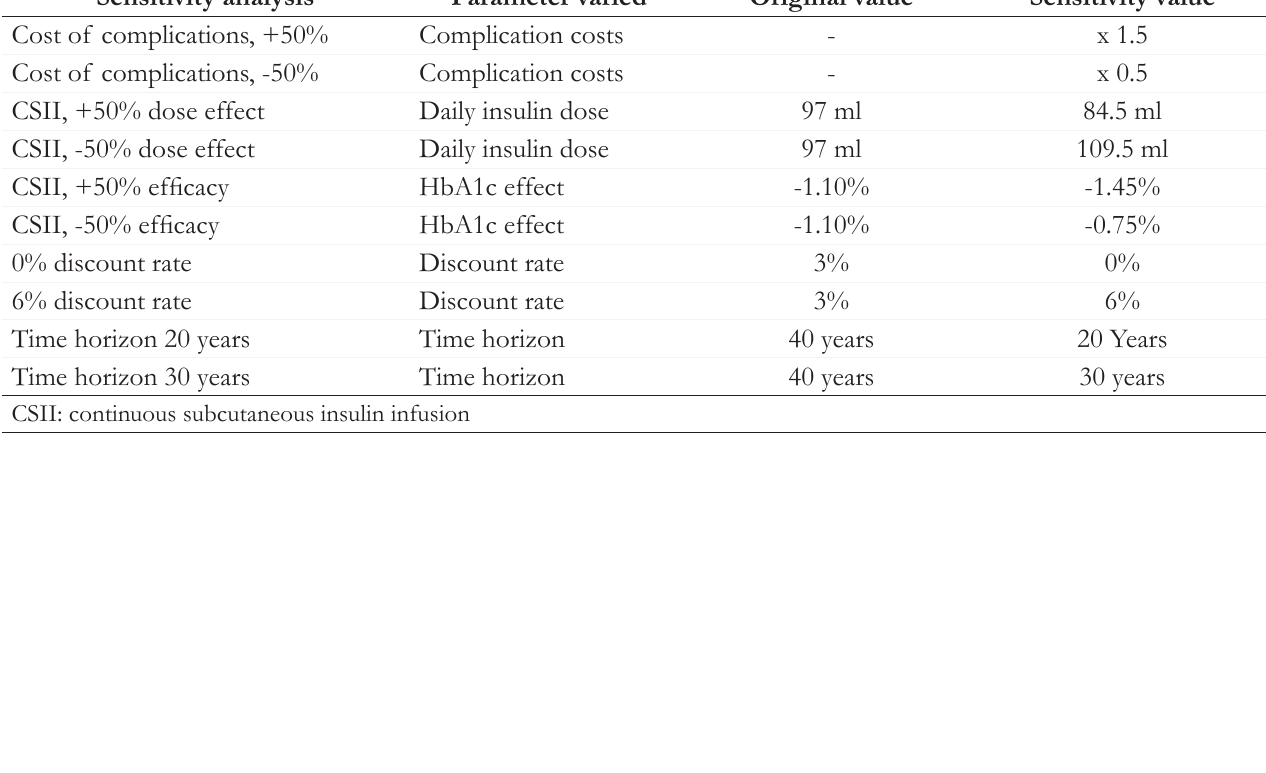
Table 5: Parameters Varied in the Sensitivity Analyses Sensitivity